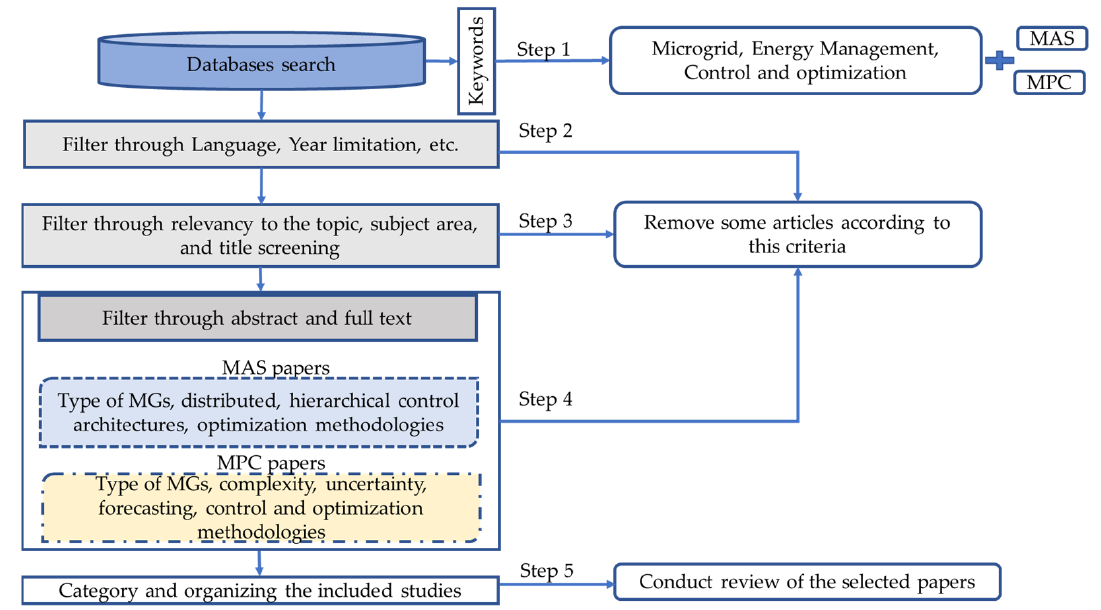
Figure 4. Categorizing the systematic literature review.